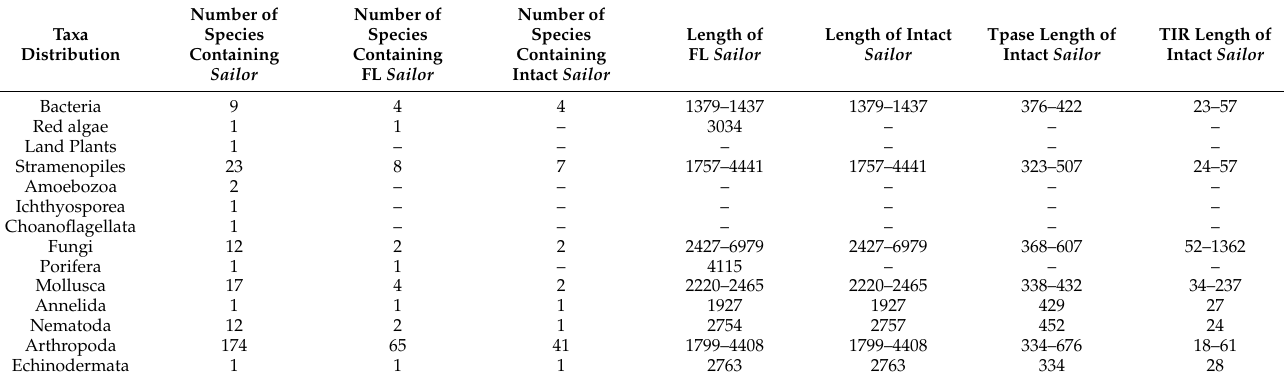
Table 1. Taxonomic Distribution of